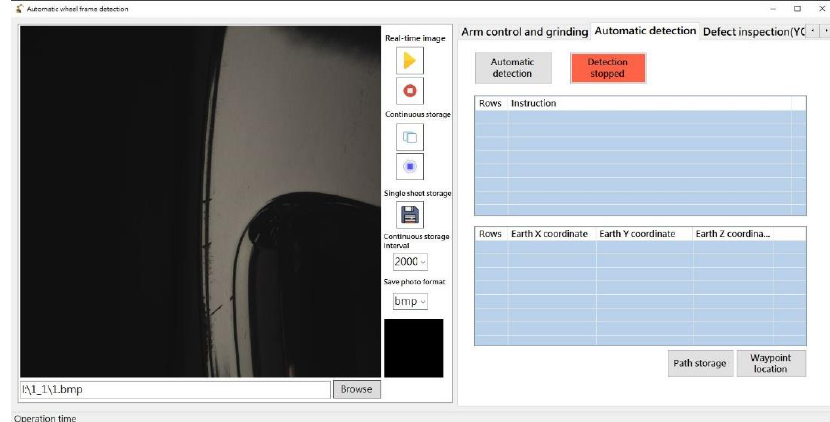
Figure 8. Automated detection interface.